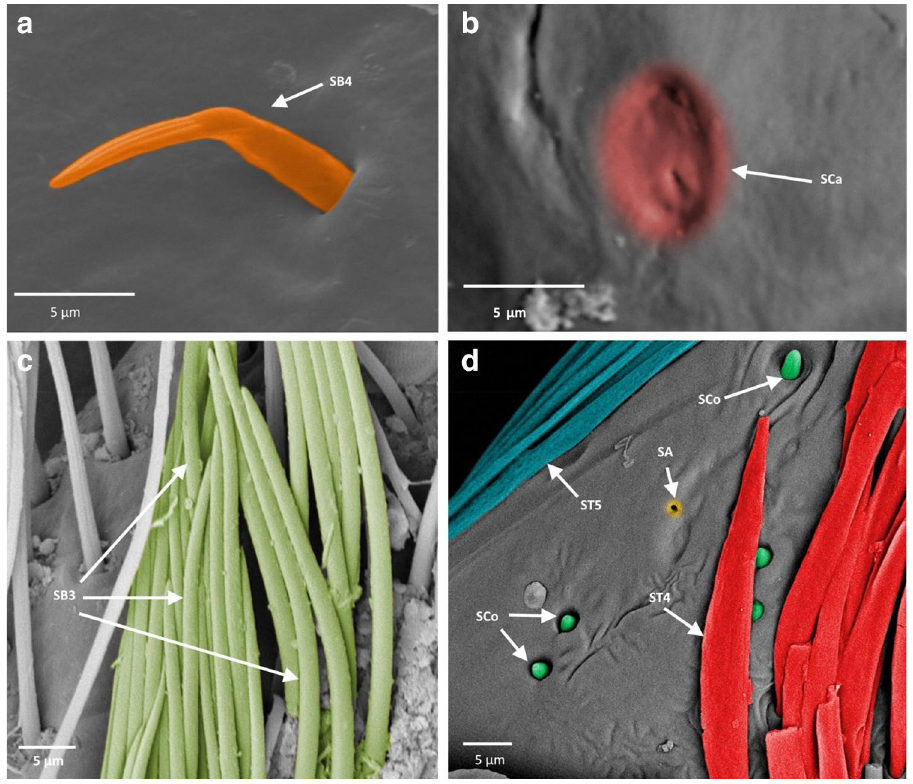
Figure 5. Antennal sensilla; ( a – c ) Asthenocoris austrialis , ( d ) Gestroiella limnocoroides . ST sensilla trichodea, SCa sensilla campaniformia, SB sensilla basiconica, SCo sensilla coeloconica, SA sensilla